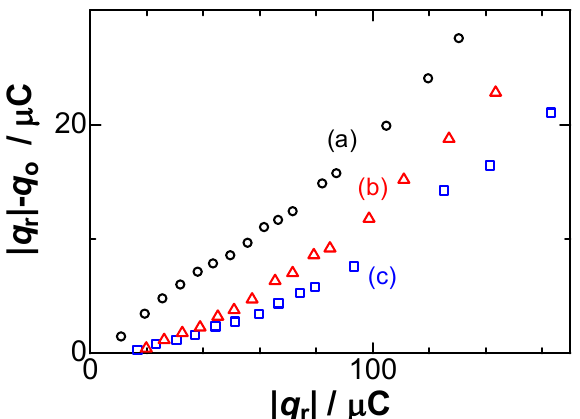
Figure 2. Dependence of the difference in the charges, q o and | q r |, on the reduction charge in the solutions of ( a ) 200; ( b ) 50; ( c ) 1 mM NaNO 3 at v = 10 mV s −1 .